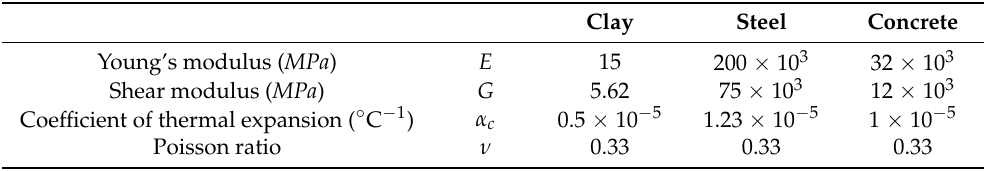
Table 3. The mechanical and thermal characteristics of homogeneous isotropic materials (Obtained from Gashti et al. [51]). Clay Steel Concrete Young’s modulus ( MPa ) E 15 200 × 10 3 32 × 10 3 Shear modulus ( MPa ) G 5.62 75 × 10 3 12 × 10 3 Coefficient of thermal expansion ( ◦ C − 1 ) α